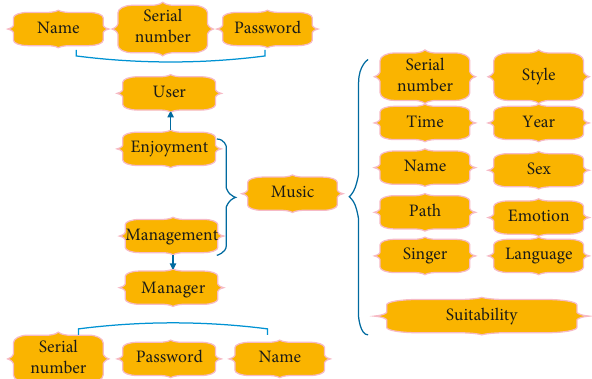
Figure 7: Entity connection diagram of the